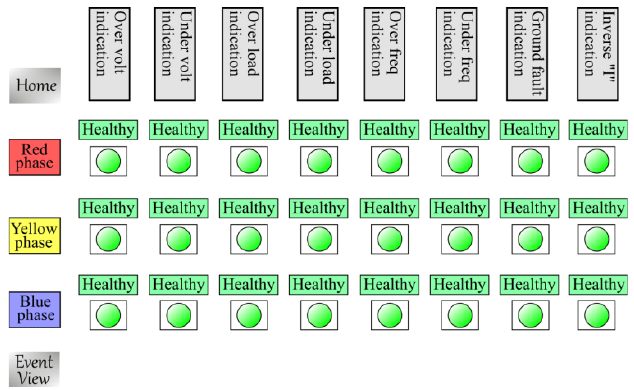
Fig. 6. Protection screen for SCADA system control according to power protection laboratory of university.